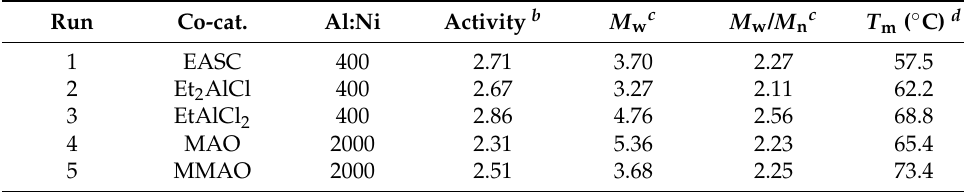
Table 2. Assessment of the effectiveness of the co-catalyst using Ni1 as precatalyst a . Run Co-cat. Al:Ni Activity b M w c M w /M n